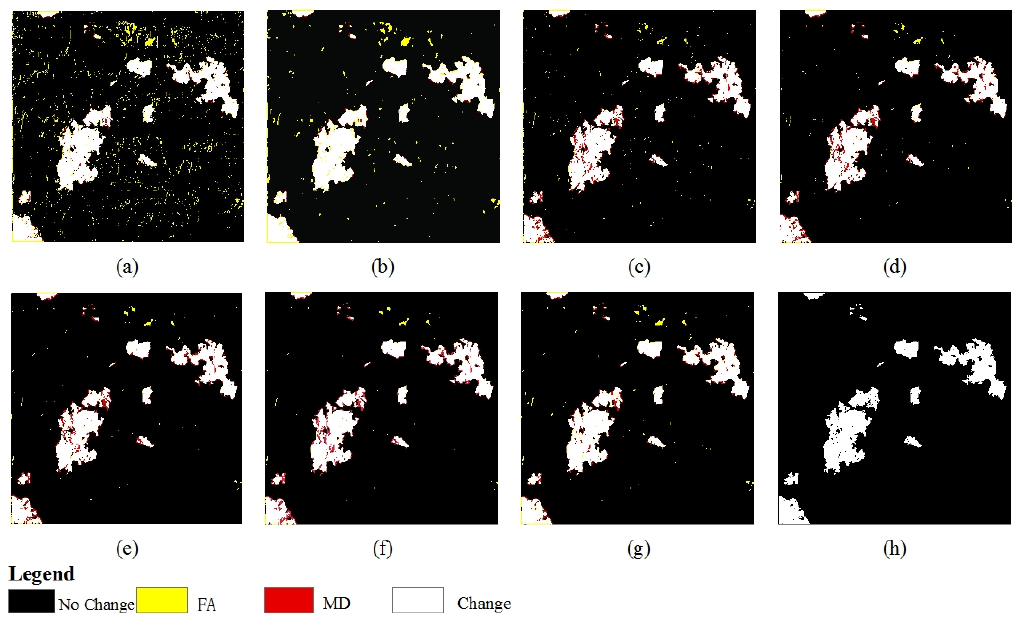
Figure 8. Final change detection maps of the Mexico dataset produced by ( a ) EM; ( b ) EMMRF; ( c ) FCM; ( d ) FLICM; ( e ) RFLICM; ( f ) sRSFCM; ( g ) proposed RSFCM; and ( h ) reference image. Remote Sens. 2016 , 8 , 264